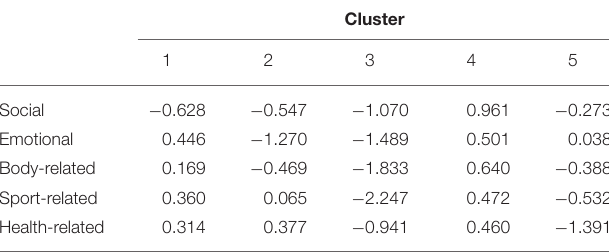
TABLE 14 | Final centers of focus. TABLE 15 | Average of individual questions, broken down of